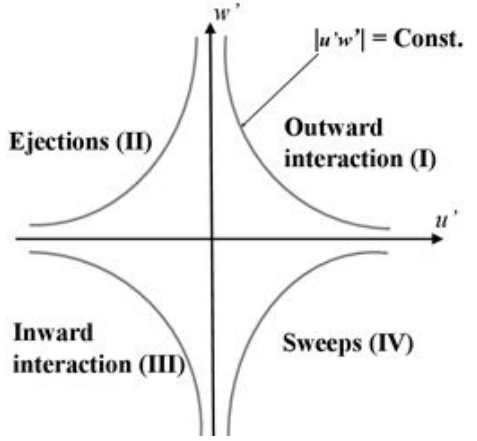
Figure 5. Quadrant analysis and bursting